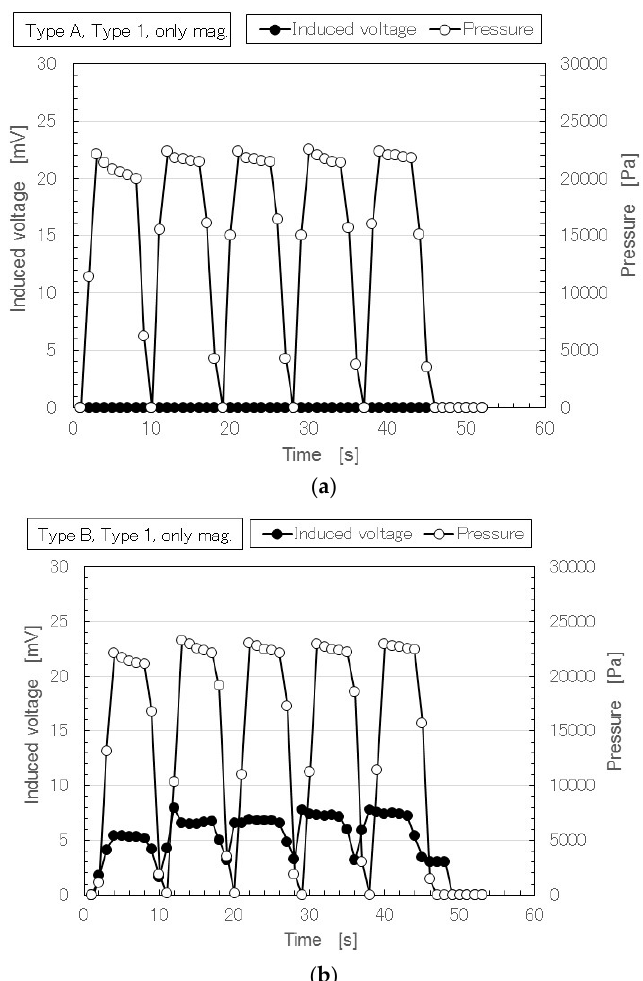
Figure 8 . Cont . Figure 8. Cont